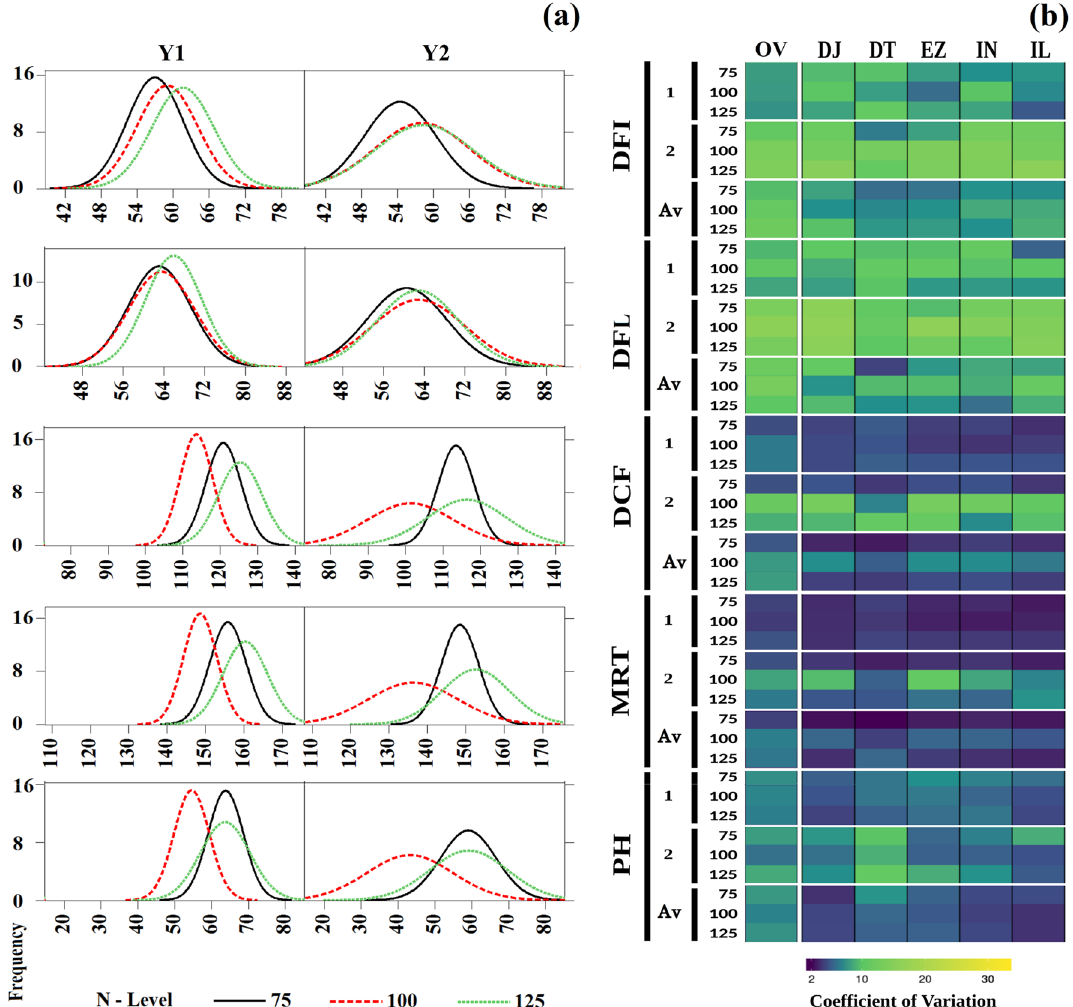
Figure 3. (a) Phenotypic variations for days to flowering initiation (DFI), days to 50% flowering (DFL), days to complete flowering (DCF), days to maturity (MRT) and plant height (PH) in Brassica juncea association panel; (b) coefficient of variations for flowering traits as compared to the days to maturity and plant